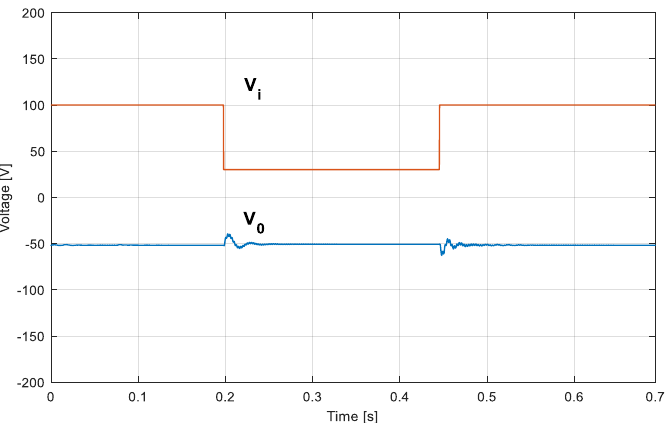
Figure 14. Simulation results of the input and output voltage in transient mode considering this converter operating with a PV system.